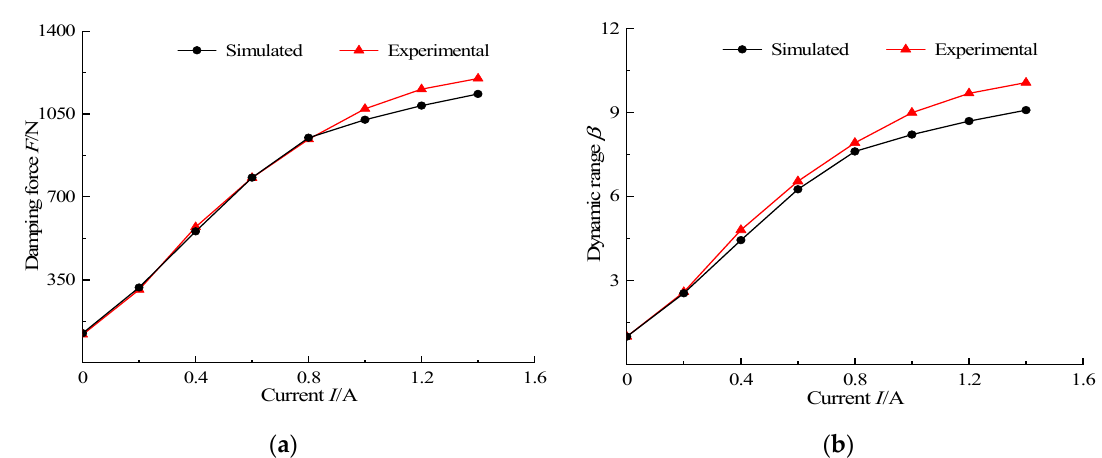
Figure 22. Simulated and experimental comparison of dynamic performance. ( a ) Comparison of damping forces under different currents, ( b ) comparison of dynamic range under different currents.